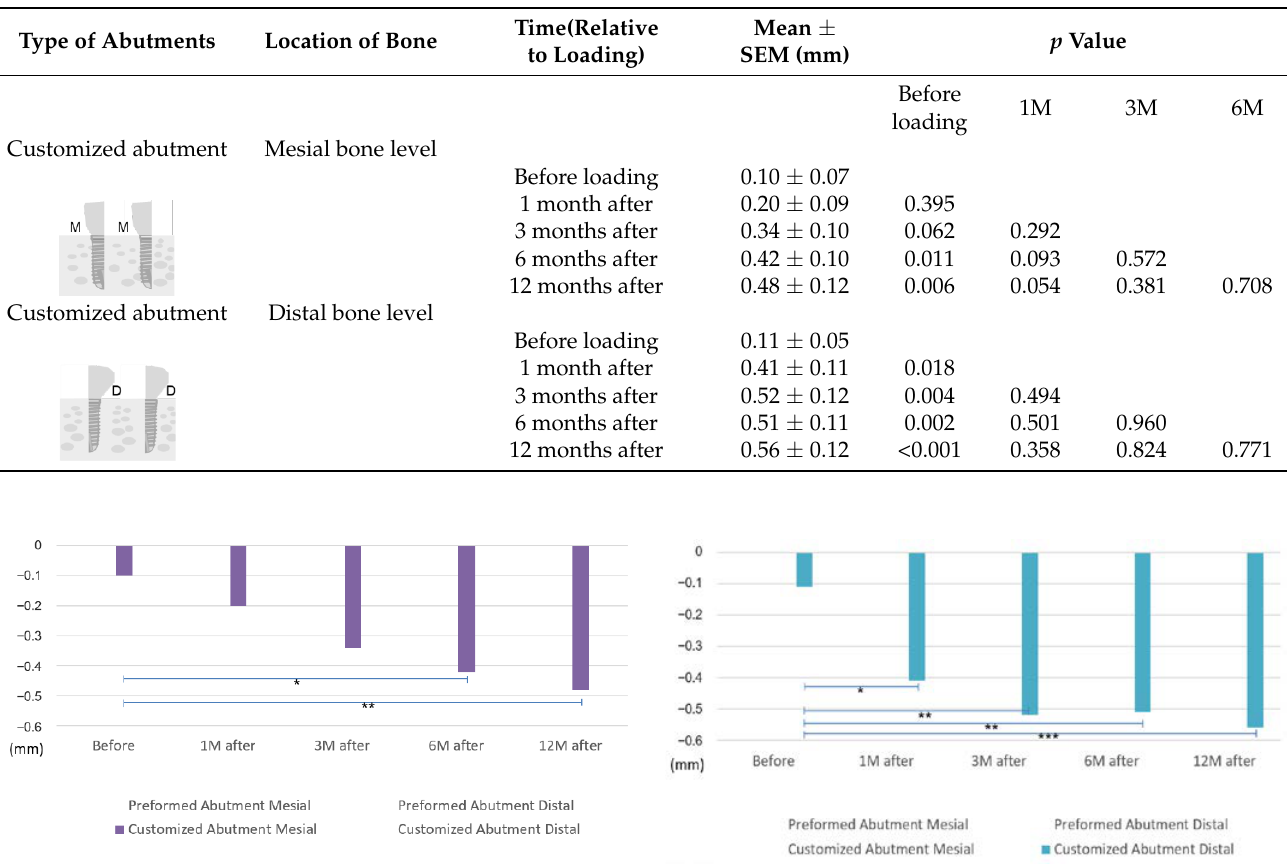
Figure 5. Comparison of the mesial ( A ) and distal ( B ) marginal bone levels in the CAs. CA, custom- ized abutment. (* p <0.05, ** p <0.01, *** p <0.001, by two-tailed T-test.)